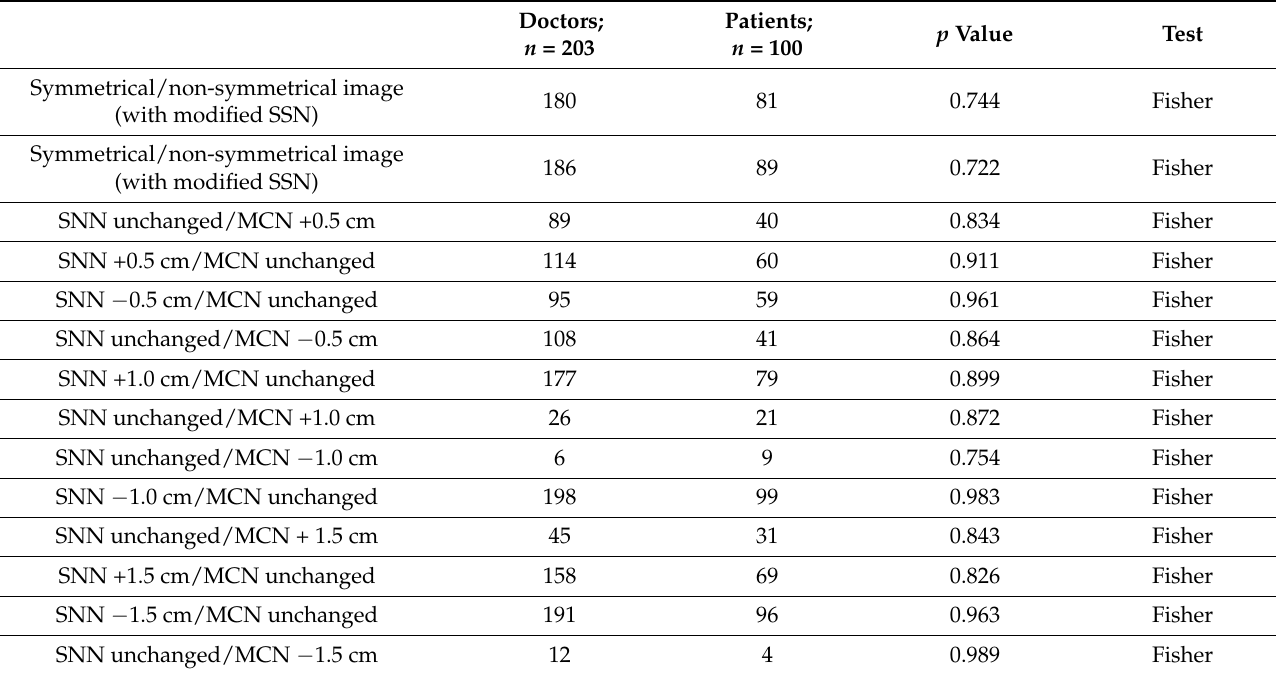
Table 1. Distinguished data between the doctor and patient